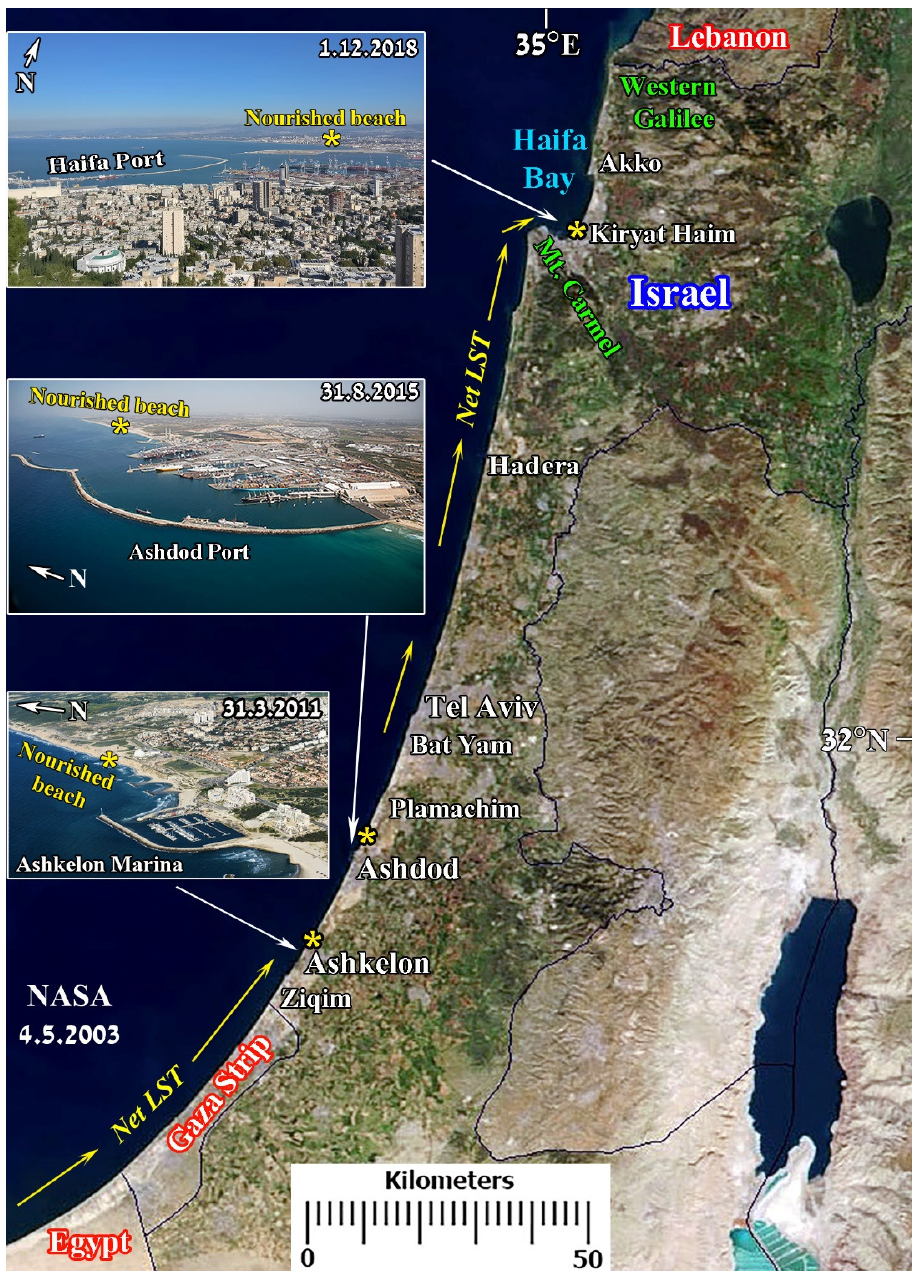
Figure 14. The Mediterranean coast of Israel and the three sites where beach sand nourishment was carried out between 2011 and 2017: south of Haifa Bay (top inset); north of Ashdod Port (central inset); north Ashkelon (bottom inset). Net longshore sand transport (LST) direction (yellow arrows). Background: part of “Middle East” space image, Jacques Descloitres, MODIS Rapid Response Team, NASA/GSFC, 31 January 2013.